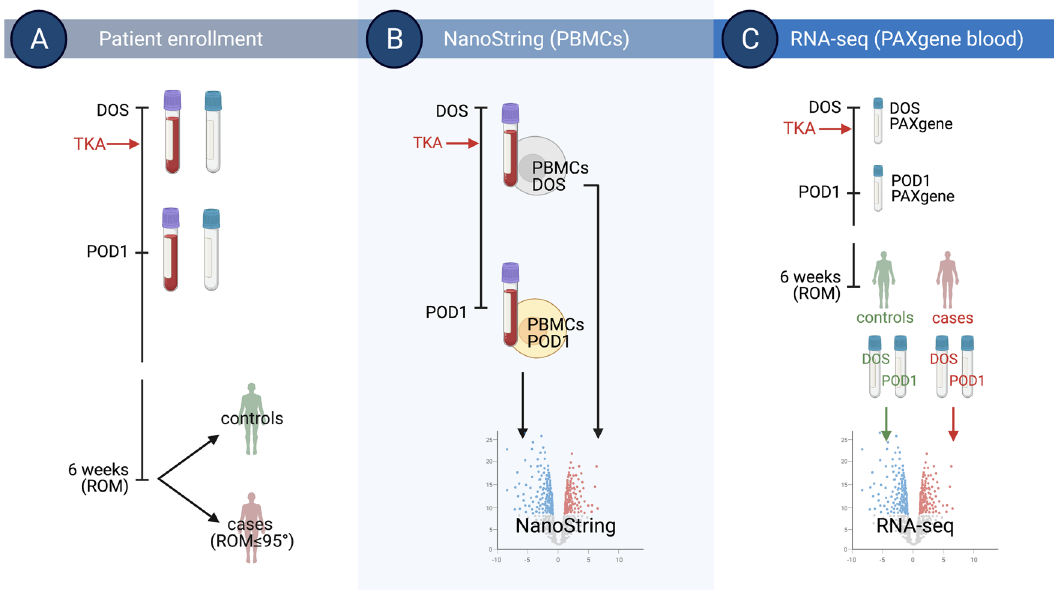
Figure 1. Study workflow. ( A ) We collected peripheral blood mononuclear cells (PBMCs) and PAXgene blood RNA tubes the day of surgery (DOS) and at 24 h after surgery (POD1) in patients with knee osteoarthritis (OA) undergoing total knee arthroplasty (TKA). At 6 weeks after surgery, patients were classified as cases and controls based on range-of-motion (ROM). Stiffness was defined as ROM ≤ 95° measured by goniometer. ( B ) RNA isolated from PBMCs was used for NanoString gene expression analyses to compare POD1 and DOS gene expression profiles. ( C ) RNA isolated from PAXgene blood RNA tubes was used for RNA-seq, comparing POD1 vs. DOS samples from controls and cases. Created with